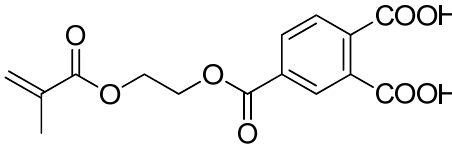
Figure 4. Chemical structure of 4-MET.